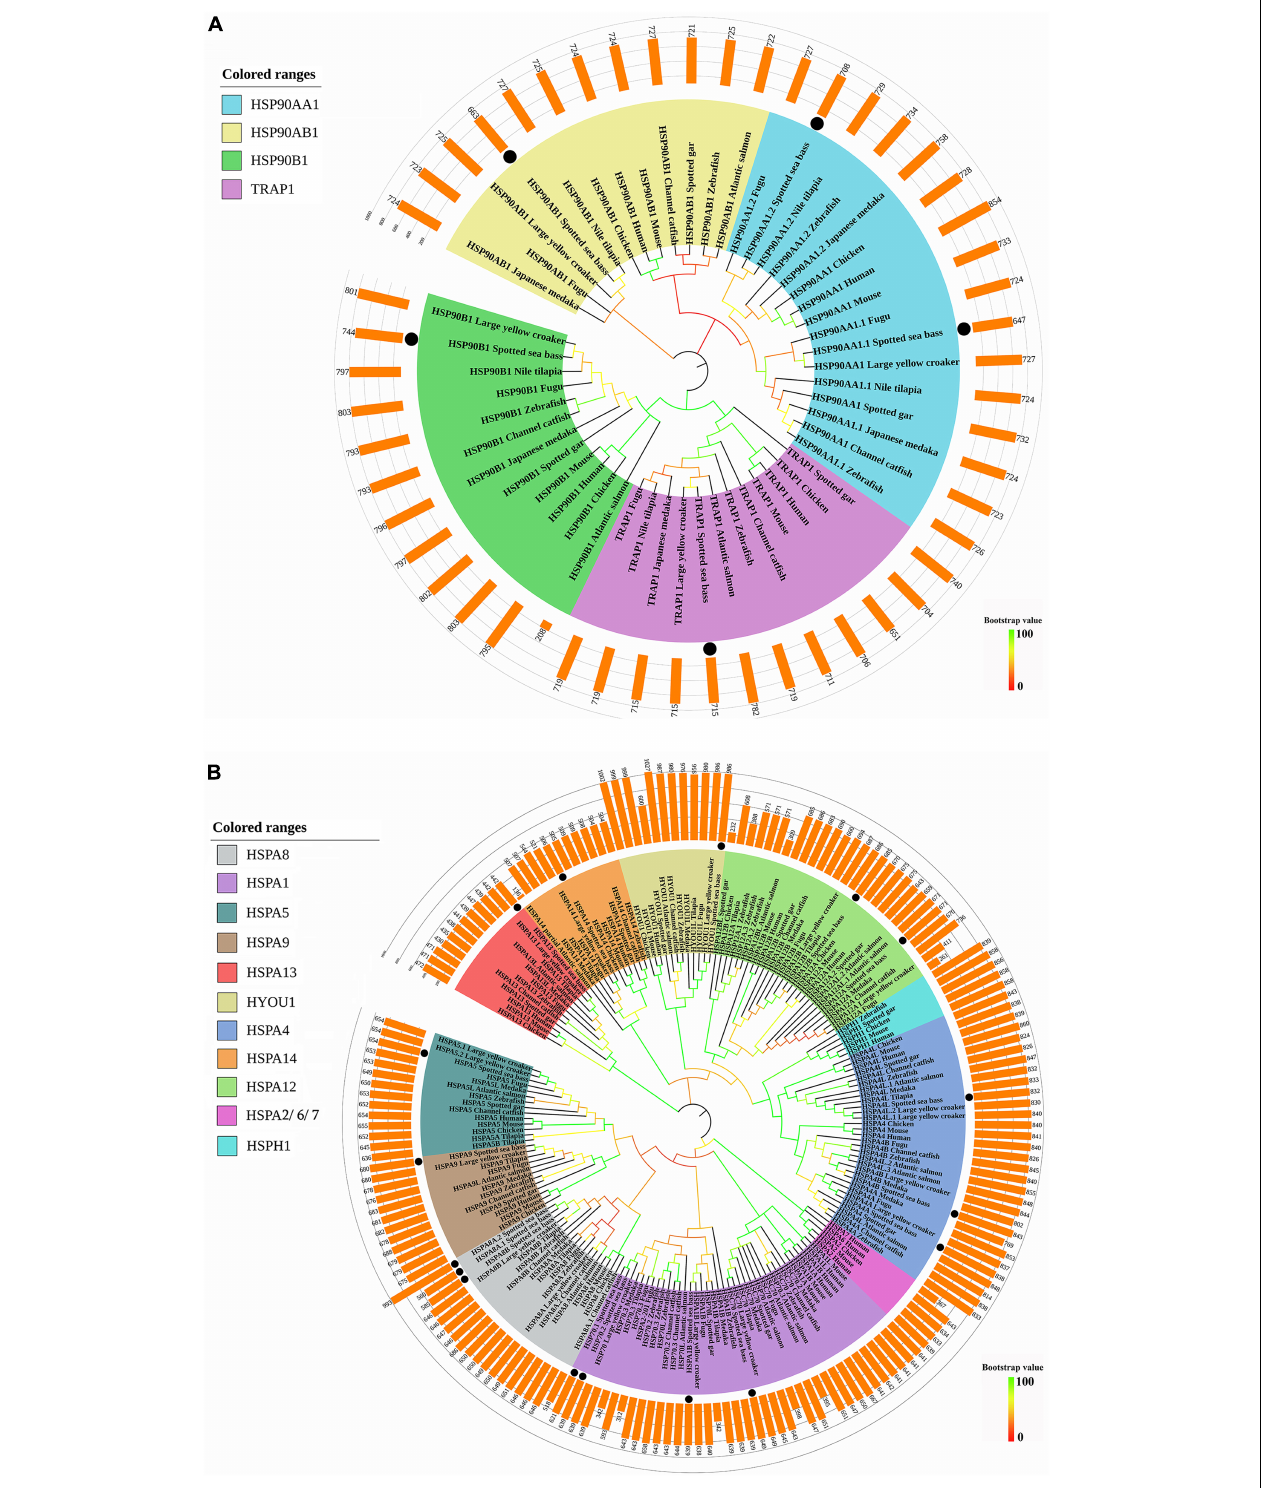
FIGURE 1 | Phylogenetic analyses of (A) HSP90 and (B) HSP70 genes. The phylogenetic tree was constructed by the deduced amino acid sequences with 1,000 bootstrap replications in MEGA 7. Different sizes of predicted amino acids of these genes were represented by the bars upon the phylogenetic tree. The black dots represented the genes of spotted